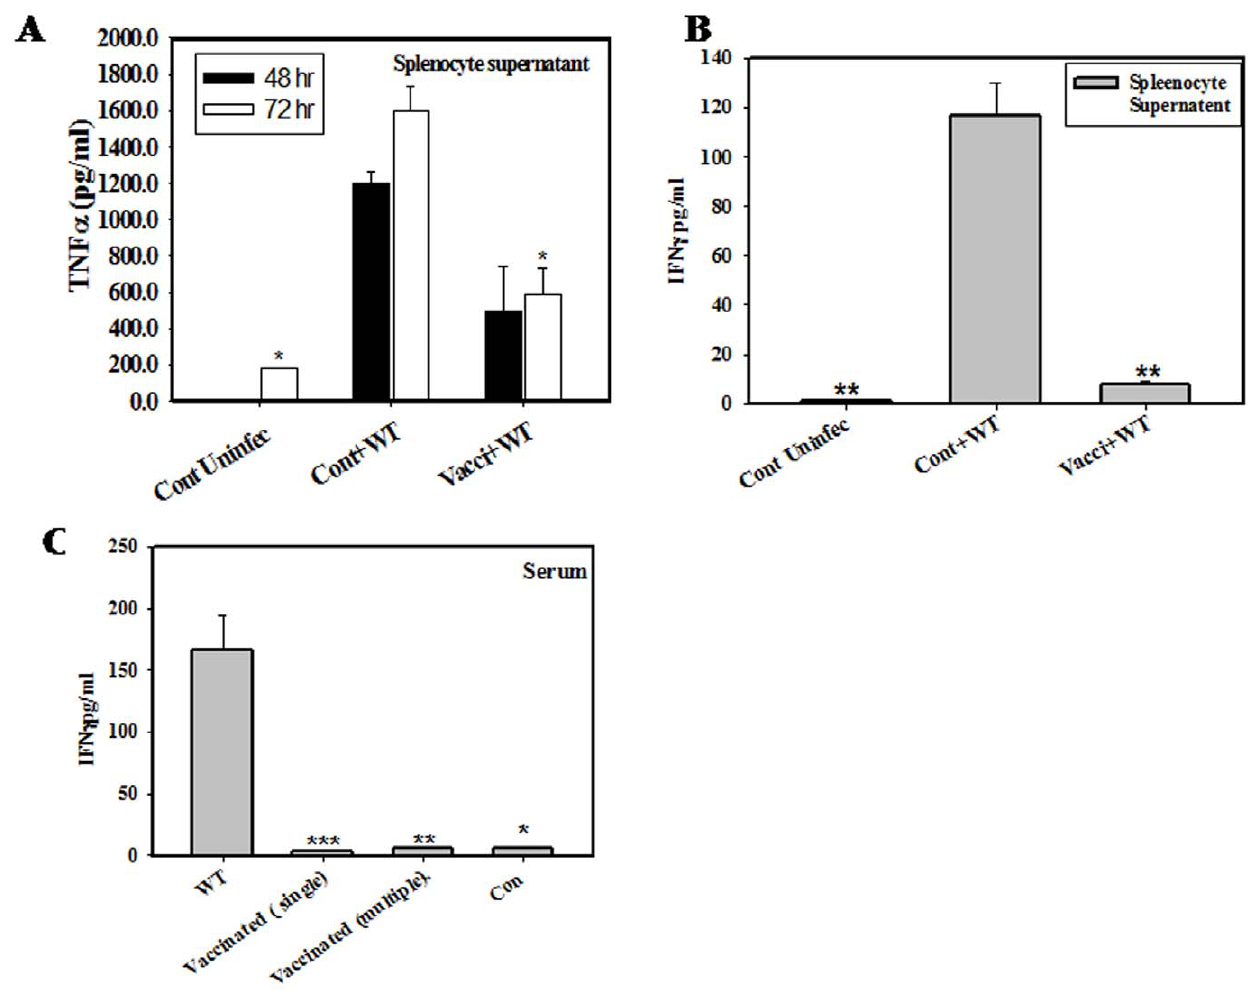
Figure 4. Th1 cytokine levels are lower in the splenocytes of vaccinated mothers. Isolated splenocytes (details in material and methods) were cultured for 48 hrs and 72 hrs. Level of TNF a (A) and INF c (B) was significantly reduced in primed splenocytes as compared to the control followed by the infection. The level of IFN c was significantly more in serum of single dose infection with WT Salmonella not in control and primed (C). Data shows the representative of three independent experiments performed. * p , 0.05, ** p , 0.001 *** p , 0.0001 (Student ‘‘t’’ test).